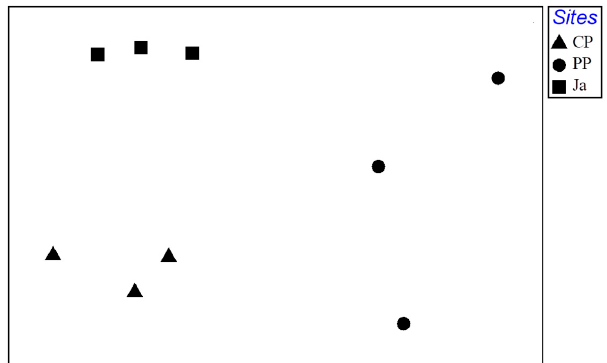
Figure 4. Nonmetric multidimensional scaling (nMDS) ordination, based on Bray-Curtis similarity matrix, for all replicates collected at each site (CP Cabo de Palos, PP Punta Prima and Ja Jávea). SIMPER analysis, based on the mollusc composition, indicated that the highest average similarities among the replicates occurred for the sites Ja (61.88%) and CP (58.06%), while that for PP replicates was only 29.94% (Table 5). The species that concurred for about 50% of similarity were mainly represented: at Ja by the suspension feeders, such as M. solidus , Rocellaria dubia , Gregariella semigranata and Hiatella arctica ; at CP by the deposit feeder Sinezona cingulata and grazer species T. tingitana and Lepidochitona sp.; at PP by the deposit feeders, such as Setia amabilis and Rissoa similis . On the other hand, the average similarity among the three sites was 31.39% (Table 6), mainly due to the suspension feeder M. solidus and deposit feeders R. similis , S. cingulata and S. amabilis . Table 5. Summary of SIMPER results for similarities in the three sites (CP Cabo de Palos, PP Punta Prima and Ja Jávea): Average similarity among replicates within each site and their average abundance of the species (Av.Abund), average similarity among replicates (Av.Sim), standard deviation of similarity (Sim/SD), percentage of contribution to similarity (Contrib%), percentage of cumulated contribution to similarity (Cum.%–50% cut-off). Cum.%